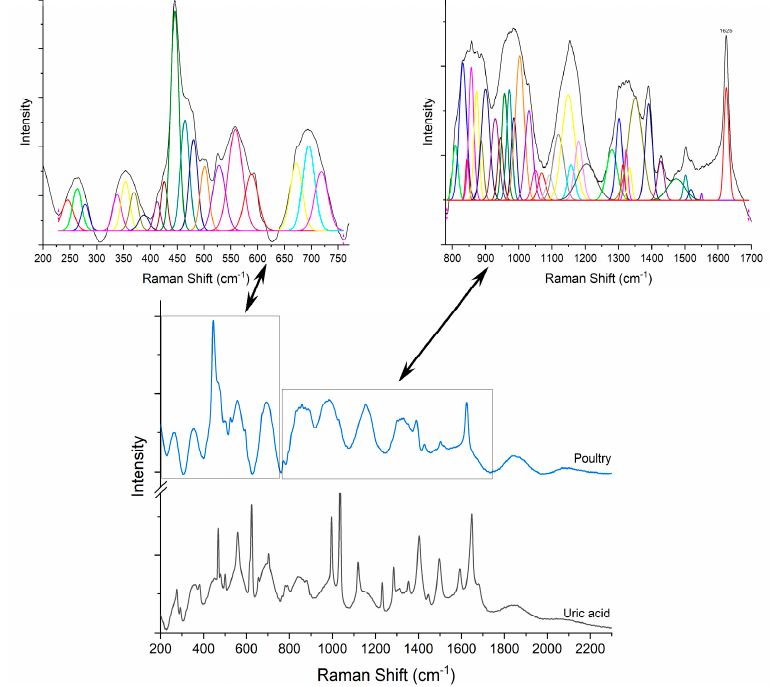
Diagnostics 2022 , 12 , x FOR PEER REVIEW Figure 7. Raman spectra of pure uric acid and, respectively, poultry sample. Figure 7. Raman spectra of pure uric acid and, respectively, poultry sample.